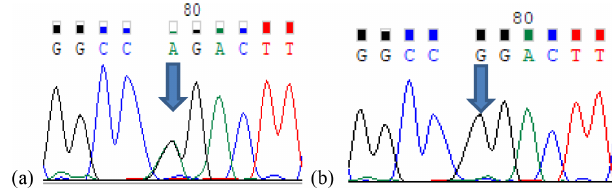
Figure 4. Partial sequence of the LTF gene showing the G → A transition. (a) Eag I heterozygote genotype (AG); (b) homozygote genotype (GG).